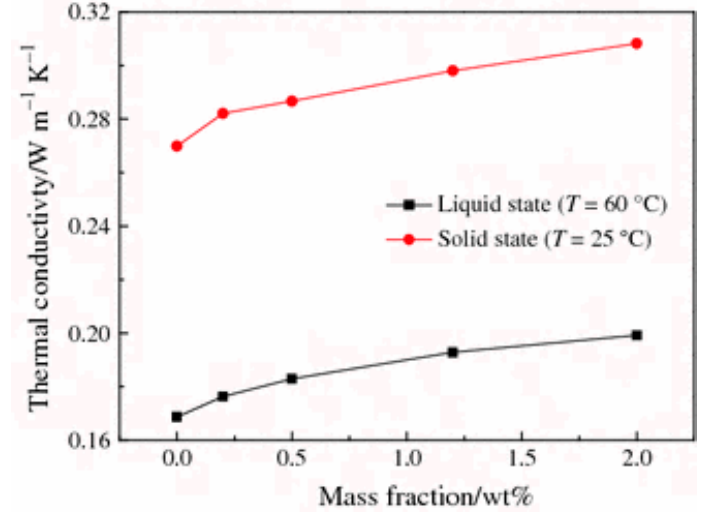
Figure 10. Increase in thermal conductivity of paraffin with increase in copper nanoparticles in the solid and liquid state. (Reprinted with Permission from ref. [51]. Copyright 2011 Journal of Thermal Analysis and Calorimetry)